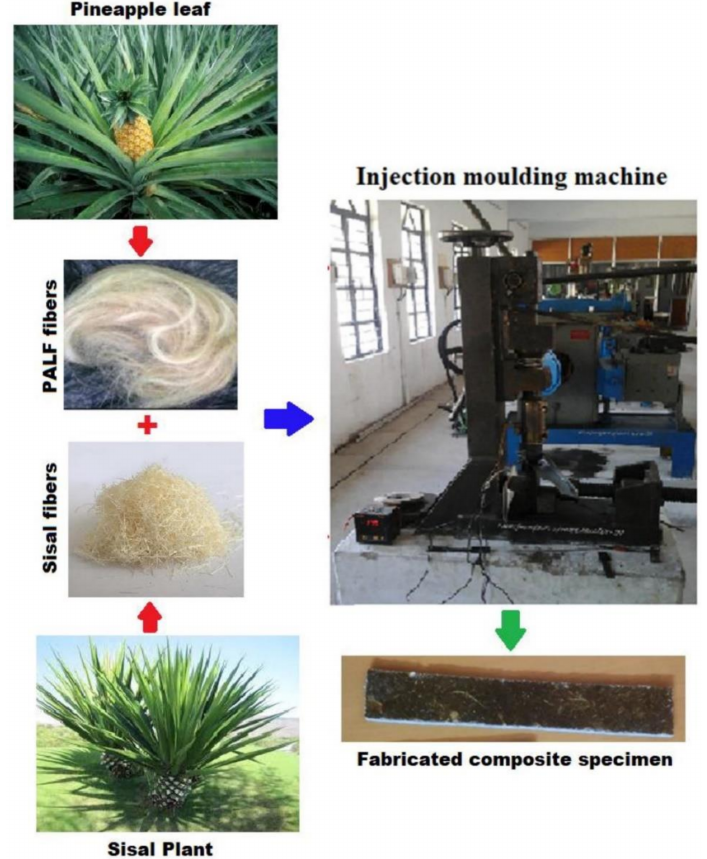
Figure 6. The fabrication process of pineapple leaf (PALF) and sisal fiber reinforced polyester composites using injection molding technique. Extracted from ref. [82] with